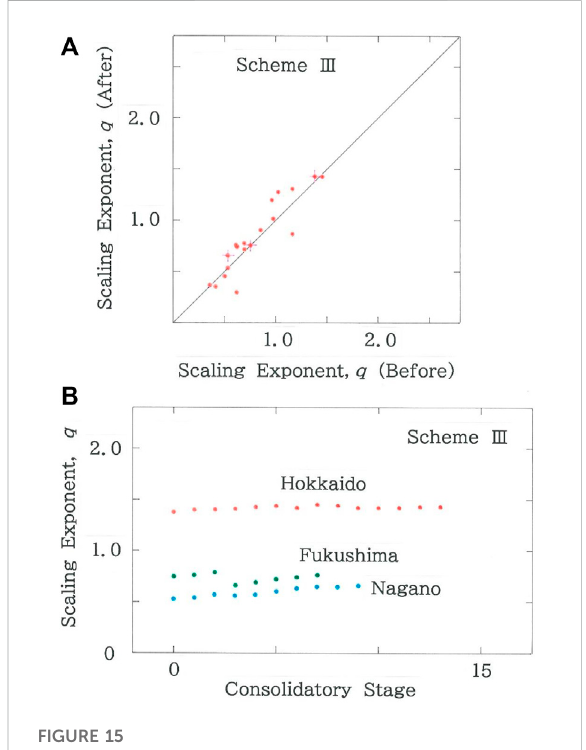
FIGURE 15 (A) Scattergram of scaling exponents after the municipal consolidations according to Scheme III versus those before consolidation ( R = 0.9119 with d = 2.942). The crosses that are superimposed on the dots highlight the three prefectures in (B) . (B) Dependence of scaling exponent, q , on the consolidatory stage. Three prefectures (Hokkaido, Fukushima, and Nagano Prefectures) are selected from (A) , which are discriminated, respectively, with the red, green, and blue